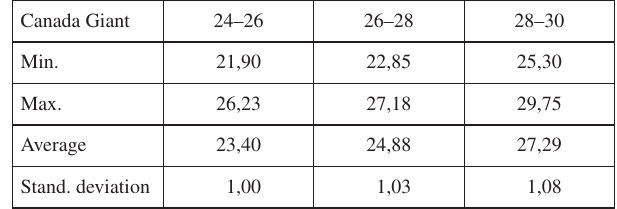
Table 1: The average values of the widths